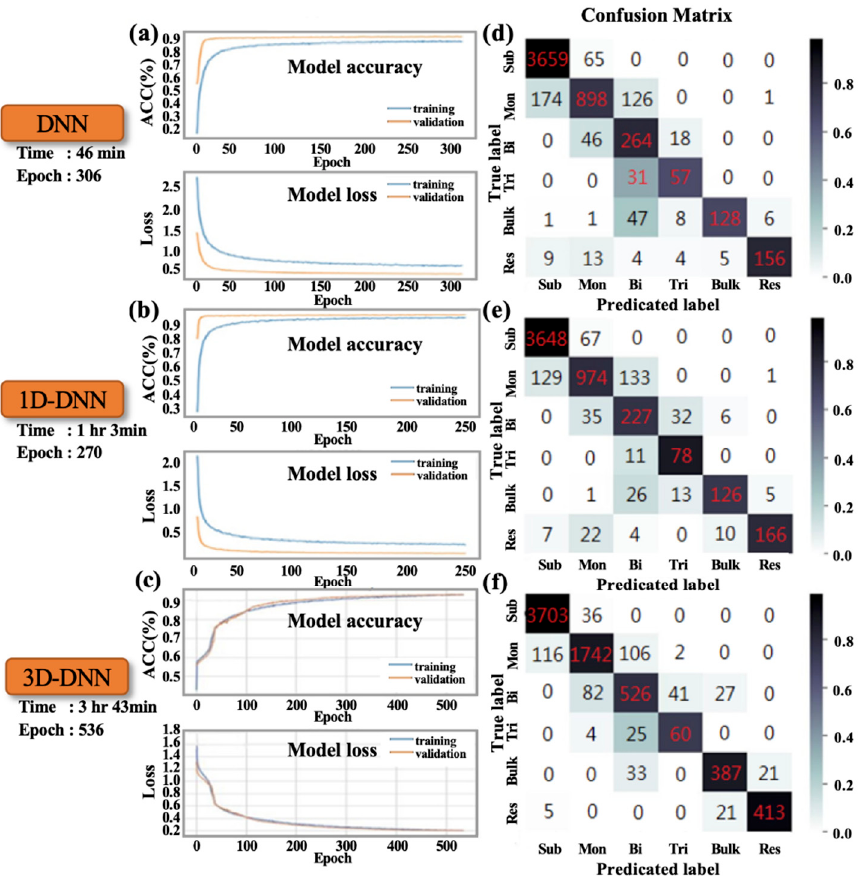
Figure 3. At 10× magnification condition: accuracy (ACC) and loss in the convergence process in ( a ) DNN, ( b ) 1D-CNN, and ( c ) 3D-CNN; confusion matrix results of the validation set in ( d ) DNN, ( e ) 1D-CNN, and ( f ) 3D-CNN. Table 1. Model evaluation indicators for the three models at 10× magnification.